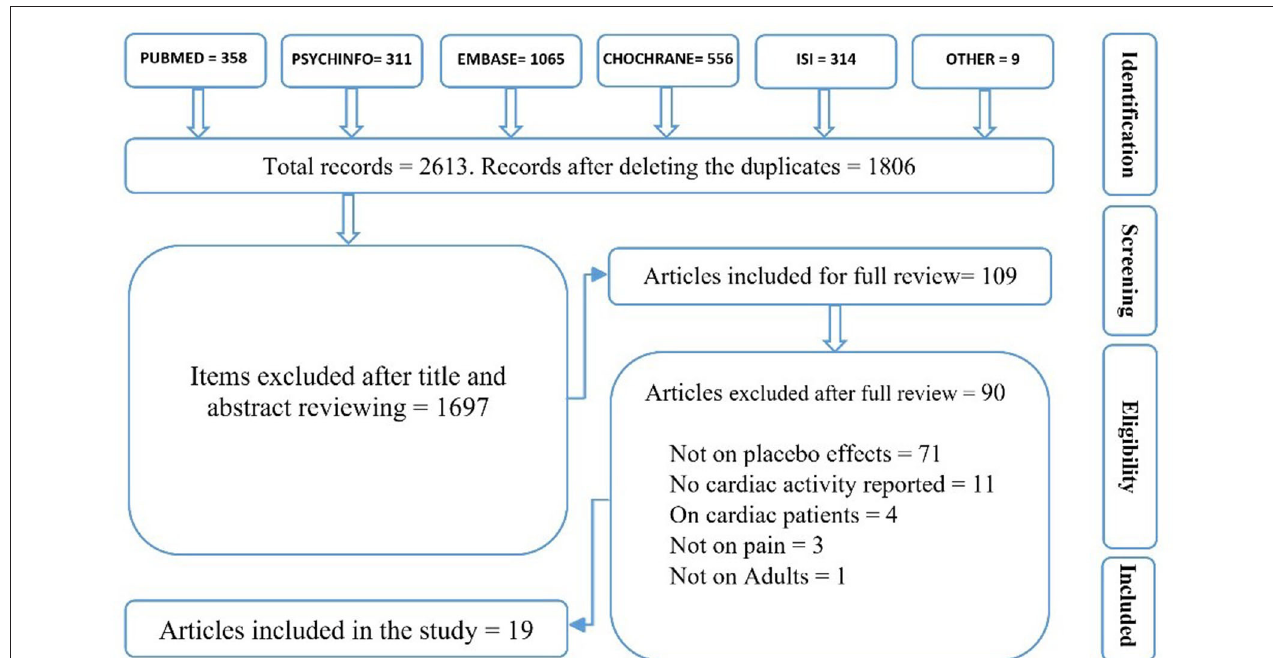
FIGURE 1 | The review flow